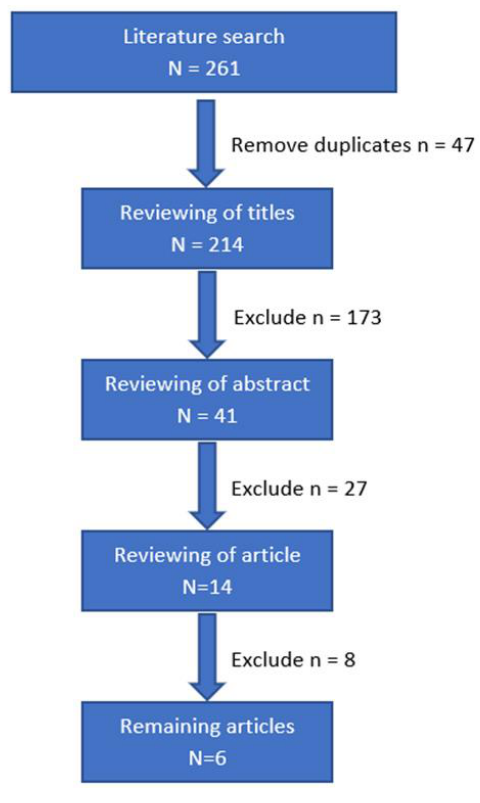
Figure 2. Flowchart of the selection process.